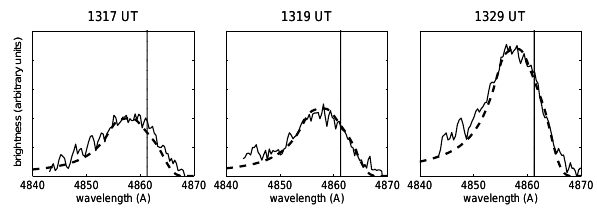
Fig. 9. Comparison of measured profiles at three different times with modeled profile, using as input the spectrum shown in Fig. 8.